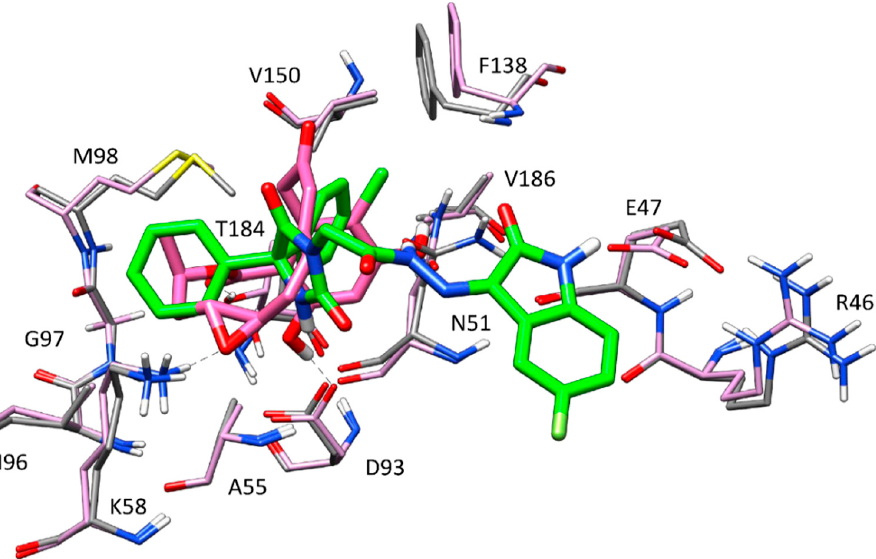
Figure 9. Superimposition of the HAA 2021 binding mode with radicicol (PDB code: 4EGK) into Hsp90. The h-bonds between radicicol (dark pink) and the protein (light pink) are shown as black dashed lines.